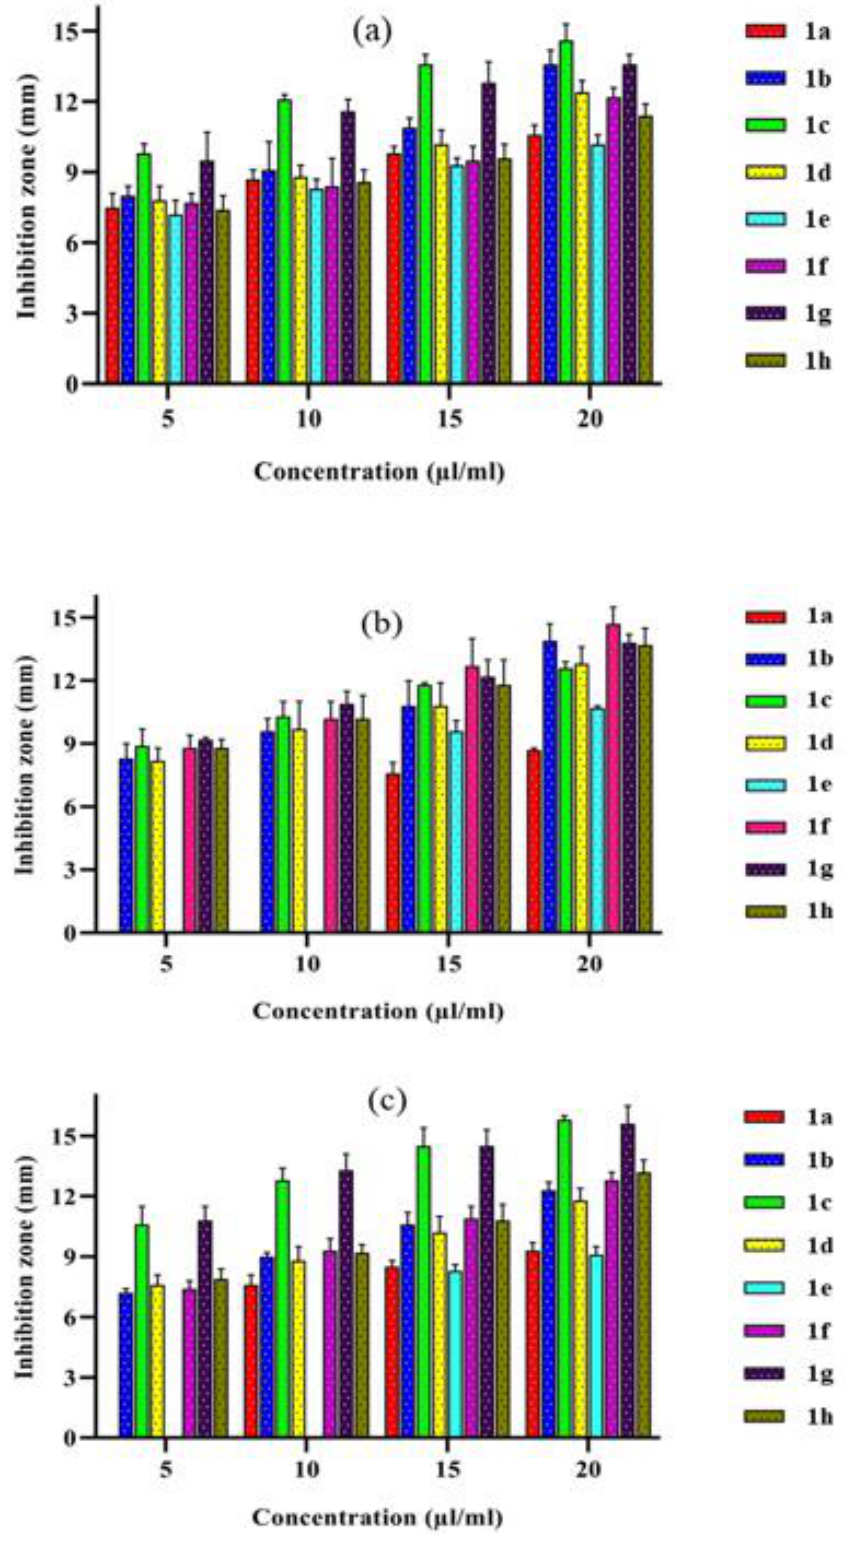
Figure 9. Antibacterial activity of metal(II) complexes ( 1a – 1h ) tested against ( a ) Escherichia coli , ( b ) Klebsiella pneumonia , and ( c ) Staphylococcus aureus bacteria at different concentrations. Table 11. Antibacterial activity of metal (II) complexes 1 ( a – h ) against pathogenic bacteria tested at various concentrations by an agar diffusion method.